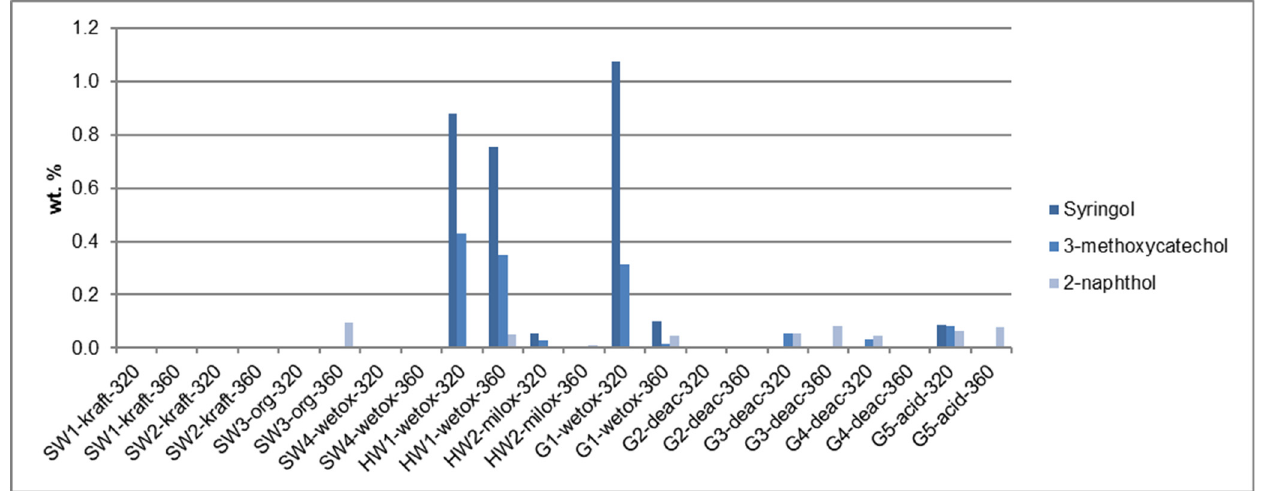
Figure 7. Quantification of syringol, 3-methoxy catechol, and 2-naphthol, given as wt.% in the obtained bio-oil.